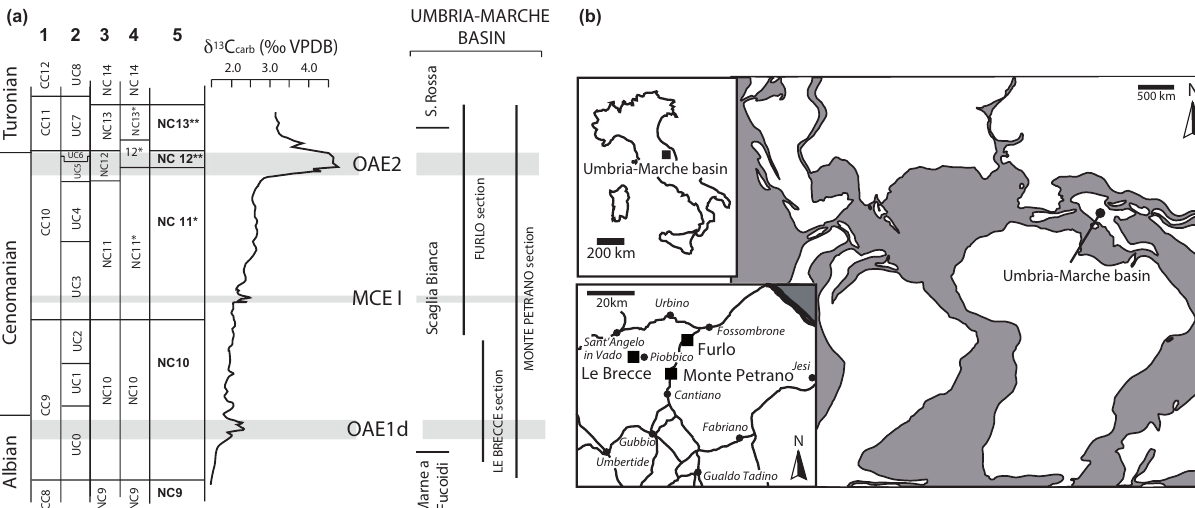
Figure 1. (a) Stratigraphic ranges of the studied sections plotted against nannofossil biostratigraphy and chemostratigraphy of the late Albian–early Turonian time interval modified after Gambacorta et al. (2015). Nannofossil zones are after the following. 1: Sissingh (1977), 2: Burnett (1998), 3: Roth (1978), 4: Bralower et al. (1995), 5: Tsikos et al. (2004), Gambacorta et al. (2015). FO: first occurrence, LO: last occurrence. (b) Present-day and paleogeographic location of the studied sections modified after Gambacorta et al. (2015).